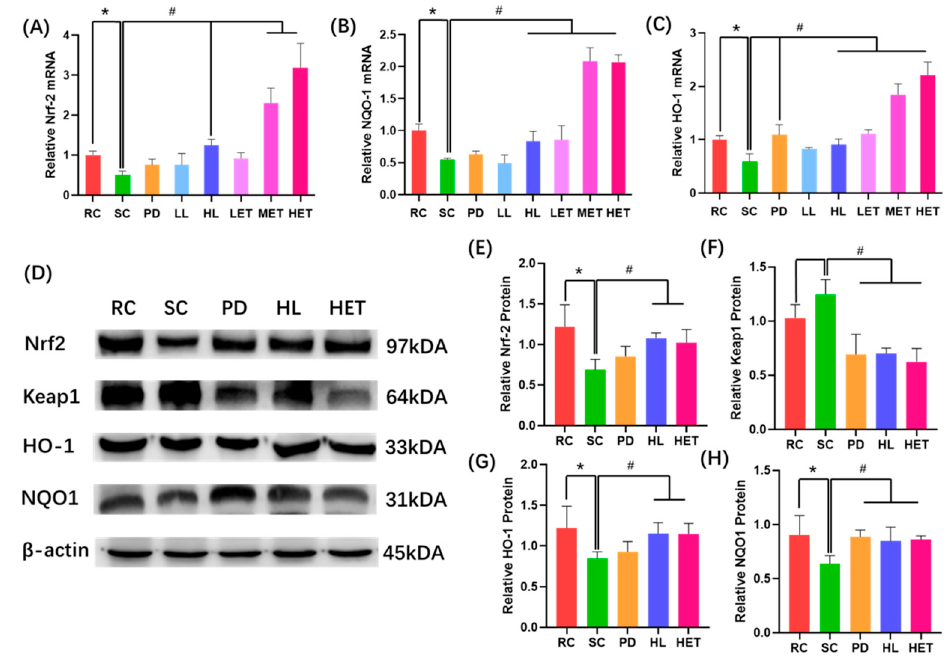
Figure 11. Molecular mechanism of LBP and LBPT regulating oxidative stress in muscle tissue of fatigue rats. ( A ) Relative expression of muscle Nrf2 mRNA, ( B ) relative expression of muscle NQO1 mRNA, ( C ) relative expression of muscle HO-1 mRNA, ( D ) expression of Nrf2/HO-1 pathway-related proteins, ( E ) relative expression of muscle Nrf2 protein, ( F ) relative expression of muscle Keap1 protein, ( G ) relative expression of muscle HO-1 protein, and ( H ) relative expression of muscle NQO1 protein. Data are expressed as mean ± SD, N = 3. *: vs. RC p < 0.05, #: vs. SC, p < 0.05.